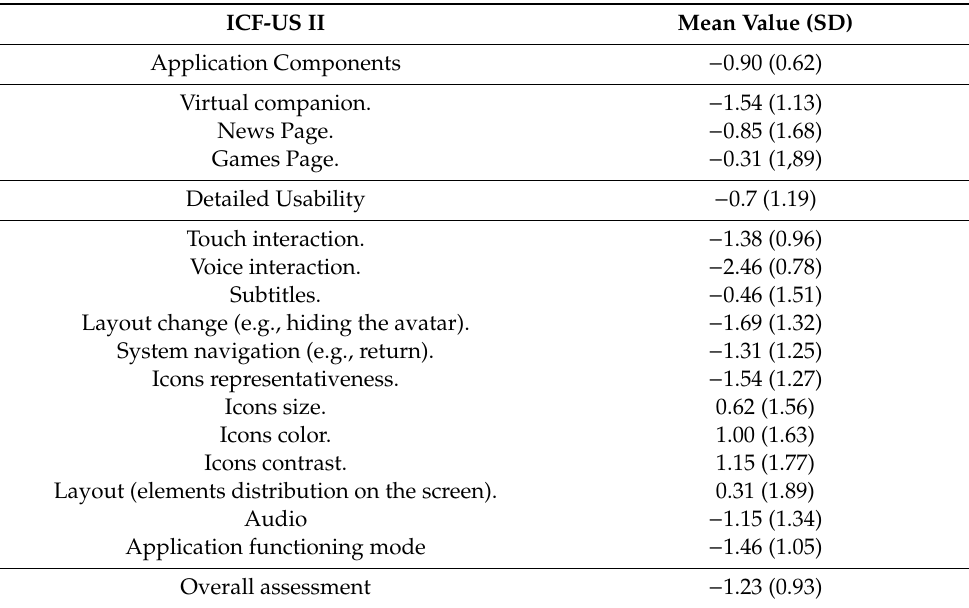
Table 4. Results of the application of ICF-US